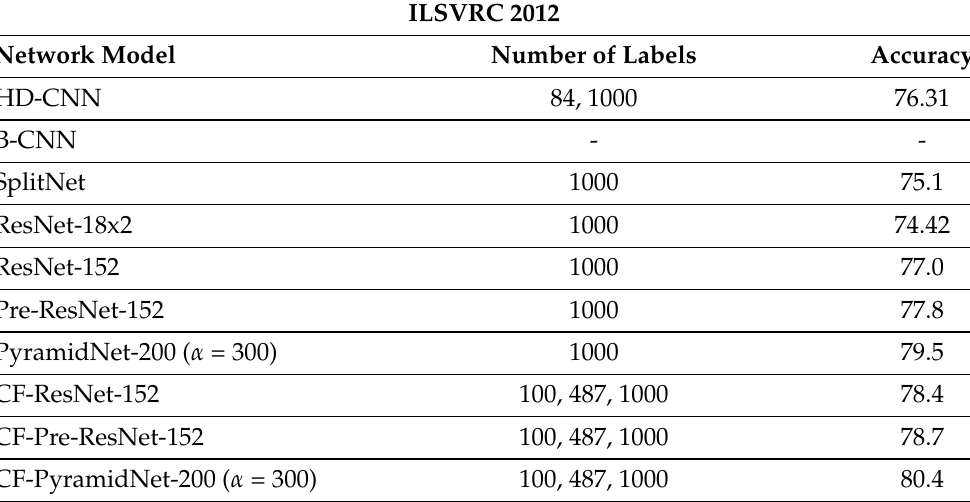
Table 11. Classification results with various classification models and grouping labels on the ILSVRC 2012